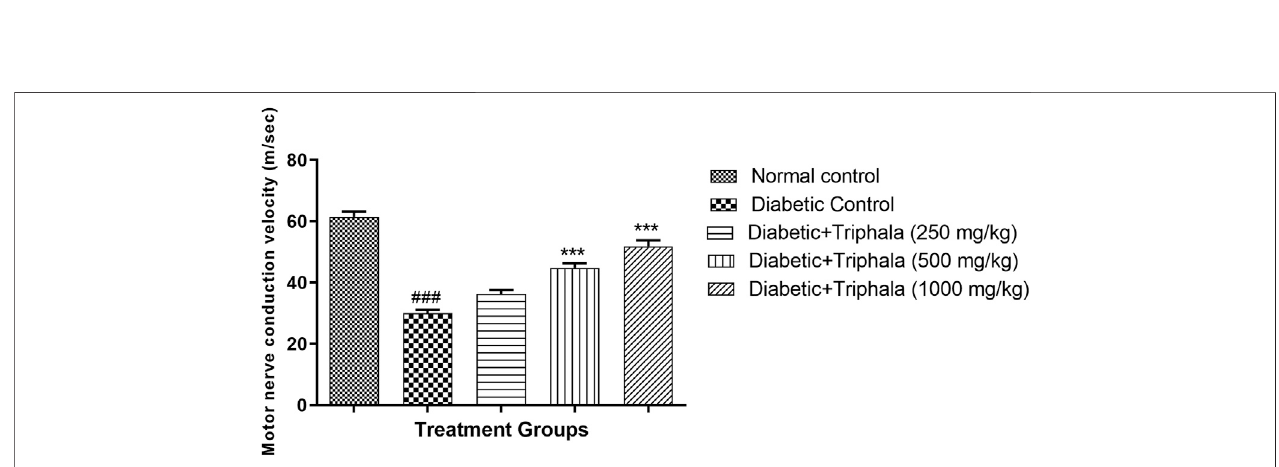
FIGURE 3 | Effect of Triphala churna on motor nerve conduction velocity. All data is expressed as Mean ± SEM ( n (cid:2) 6), ### p < 0.001 when compared with normal control, *** p < 0.001 when compared with diabetic control.